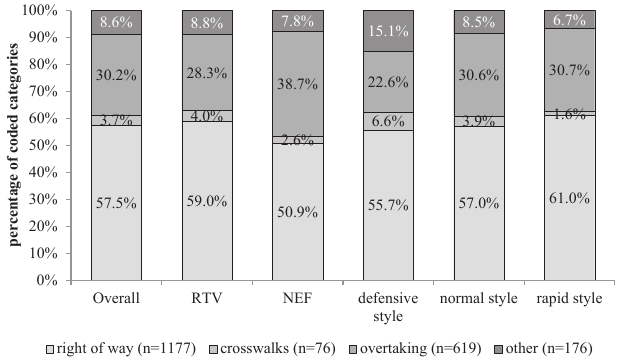
Figure 2. Overview of the PCDS types for the overall data as well as by vehicle type and driving